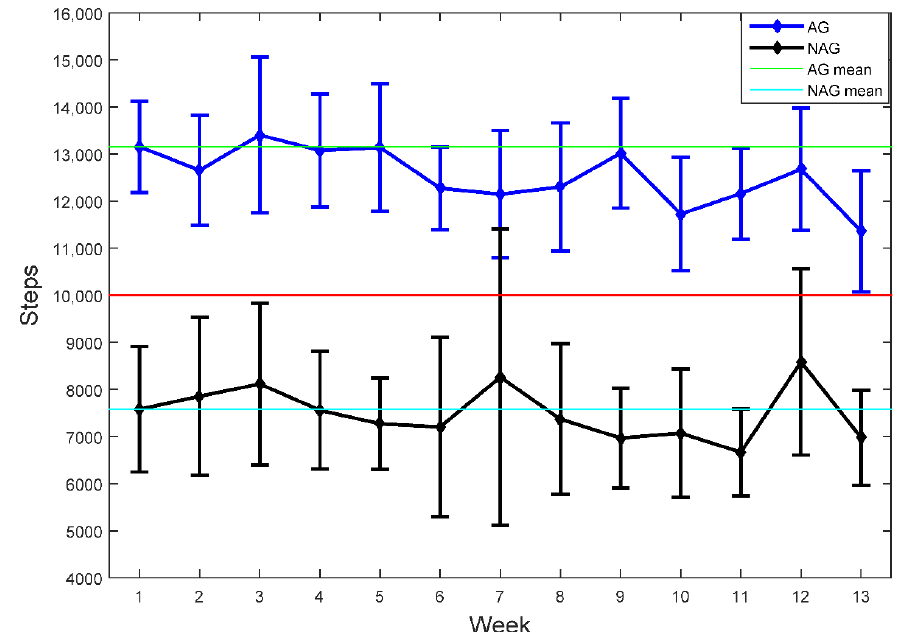
Figure 1. Daily mean steps (and 95% confidence interval) per week for AG (Active Group) and NAG (Non-Active Group). Red line indicates the recommendation of 10,000 steps/day. Green line and cyan line indicates the daily mean steps at baseline for the AG and NAG, respectively.